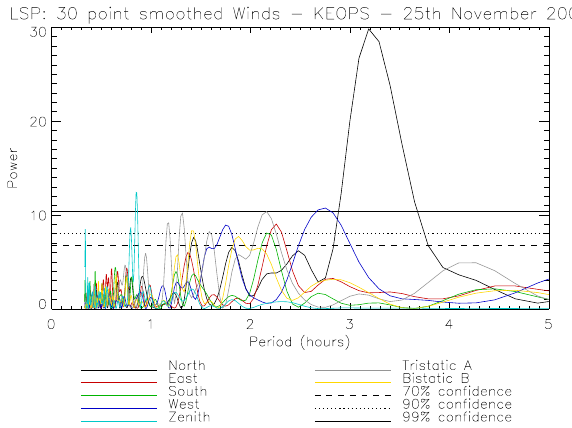
Fig. 7. Periodogram from KEOPS wind data with a 30 point ( ∼ 10min) smoothed value removed, for the 25 November 2003.